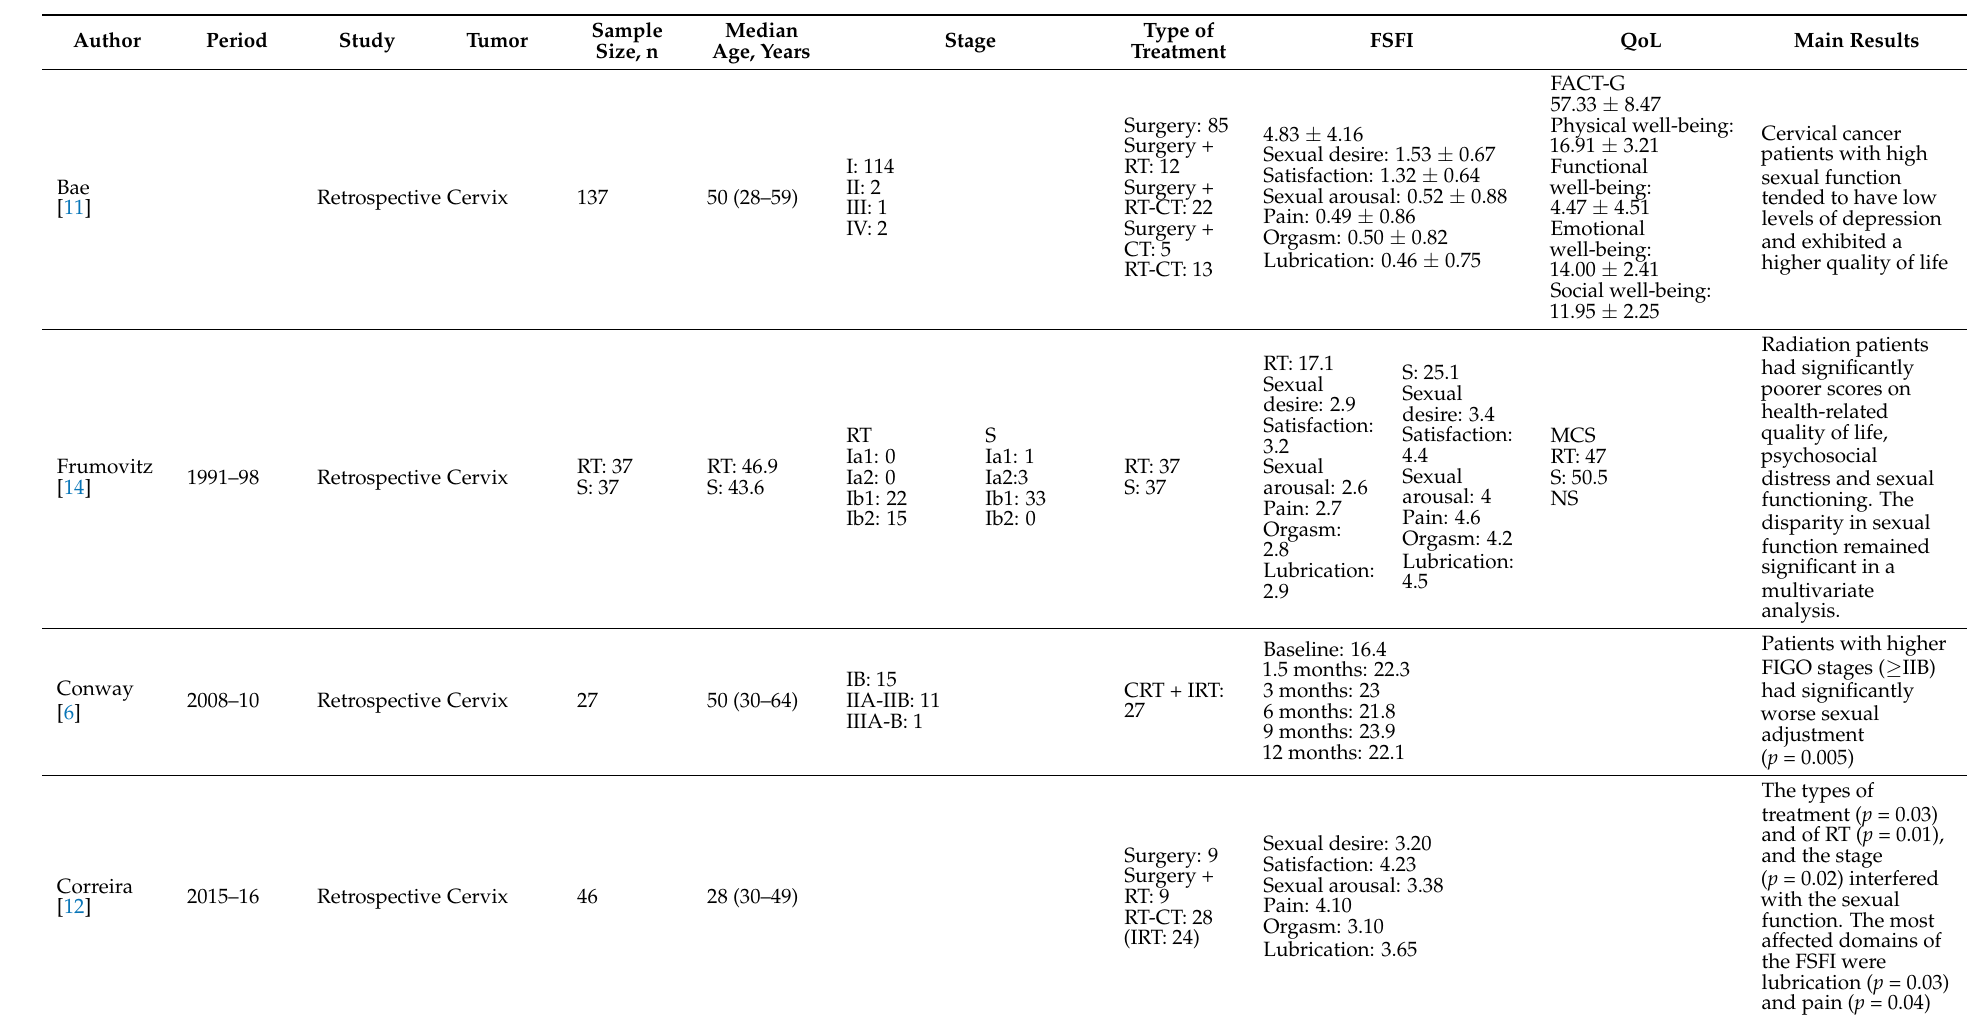
Table 1. Patient demographics, treatment characteristics, OS, LC, DFS, MSS and